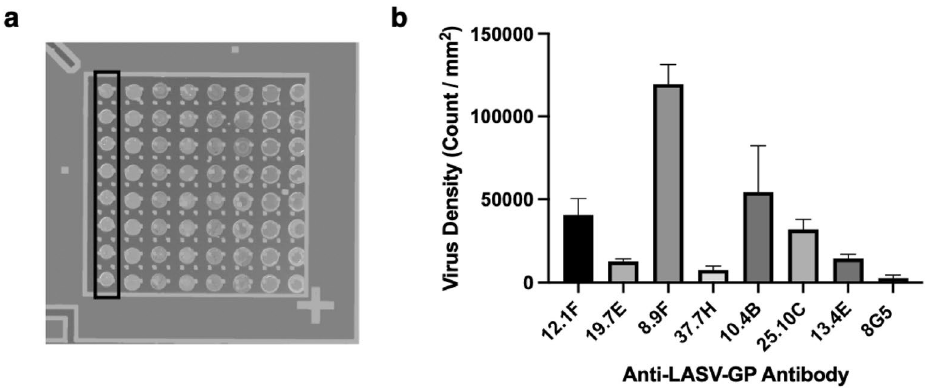
Figure 4. Screening of anti-LASV GP antibodies on SP-IRIS. ( a ) Image of the SP-IRIS chip spotted with eight of the Lassa antibodies. Each column, shown by the black rectangle, represents one antibody type. The rest of the antibodies were spotted on a different chip. Spots have a diameter of approximately 150 μm. ( b ) Average virus densities captured on each antibody for 8 replicate spots following an incubation with 10 7 PFU/mL rVSV-LASV for 1 h. Wild-type VSV-specific 8G5 antibody was also spotted on the chip to obtain the detection threshold, which is calculated as 7700 particles/mm 2 . Only the antibodies that had a signal over the